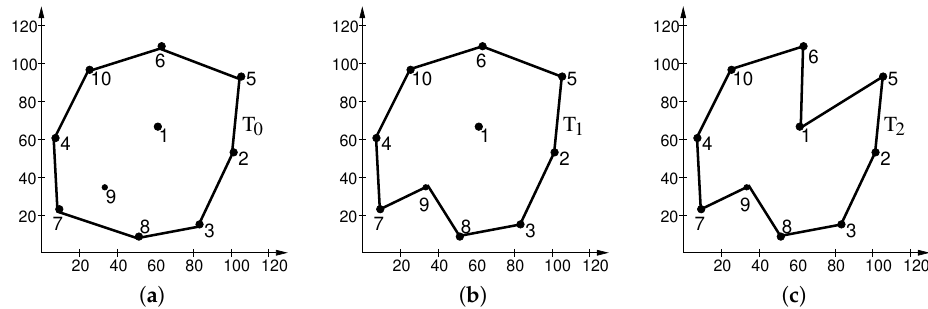
Figure 7. Iterations made by the insertion algorithm to solve the example instance “tsp10”. ( a ) The tour T 0 = ( 6,10,4,7,8,3,2,5,6 ) is delivered by ( GIRDING _ POLYGON ( V ) ). ( b ) Vertex 9 is inserted between vertices 7 and 8. ( c ) Vertex 1 is inserted between vertices 5 and 6. The feasible tour constructed is ( 6,10,4,7,9,8,3,2,5,1,6 )